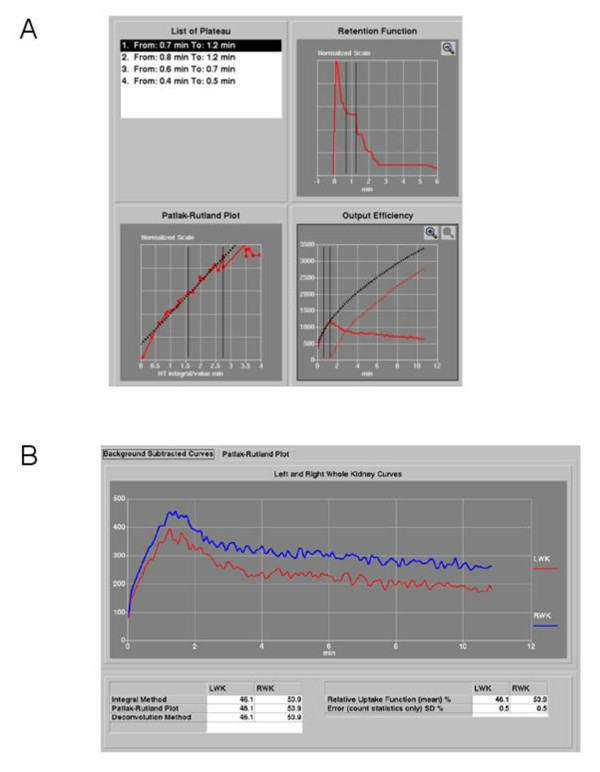
Calculation of FUR. (A) Example of the LU segment in the Patlak-Rutland plot. (B) DRF calculated as the percentage contribution to total uptake from the left and right kidneys.